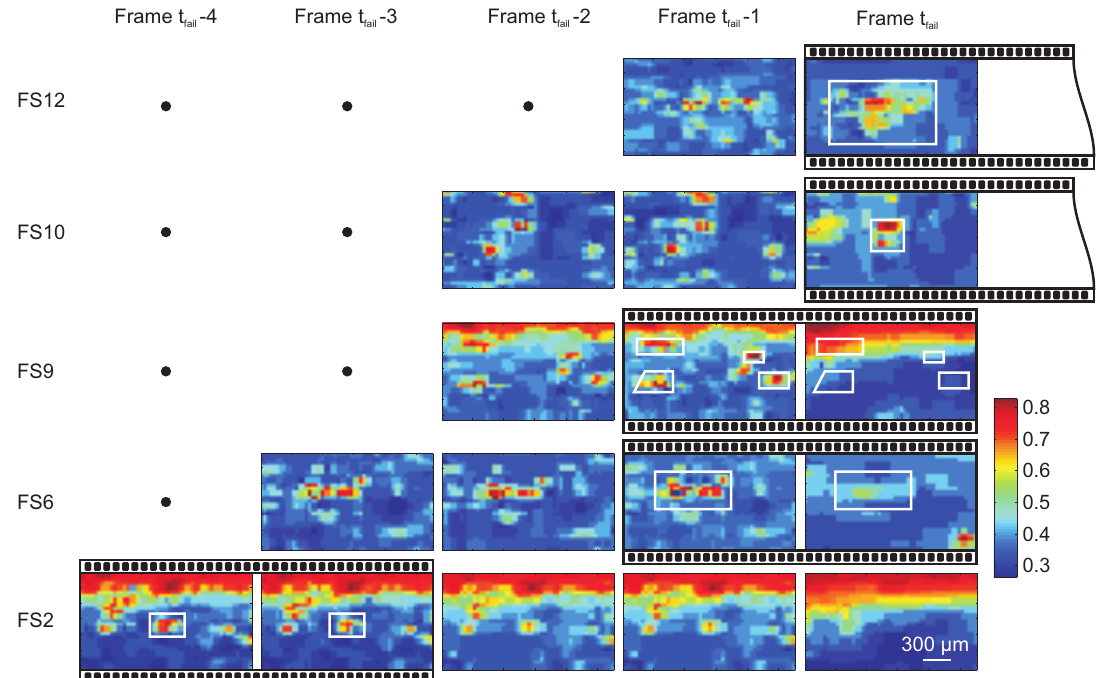
Figure 13. Final five frames prior to SS2 detailing the images taken in the location of each foreshock shown in Figure 12a. Changes in light intensity occurring between frames are highlighted by the bordered black boxes. Frame F +1 was not shown, since it was tfail blurred. White boxes give an estimate of the regions in which light intensity